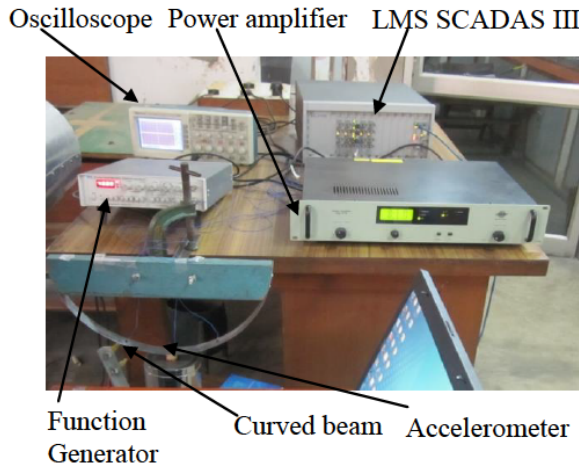
Figure 1: Experimental Setup.